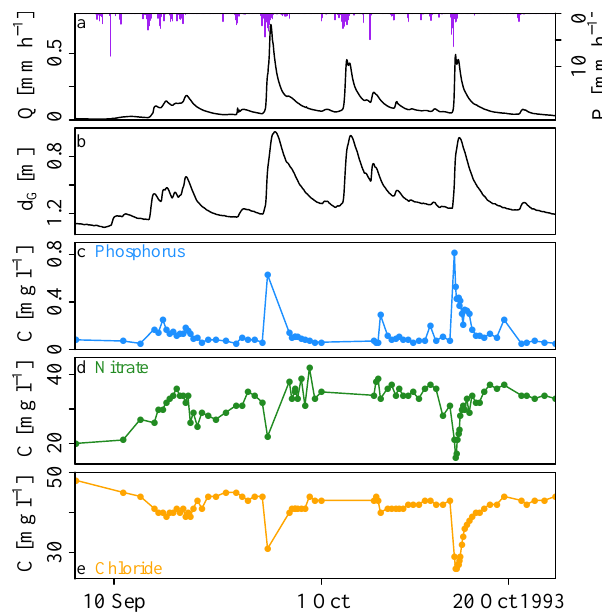
Figure 3. Activation of different flow paths revealed by water qual- ity data measured at the outlet of the Hupsel Brook catchment. (a) Precipitation and discharge. (b) Groundwater depth at the mete- orological station. (c) Phosphorus concentration (indicator for over- land flow, Rozemeijer et al., 2010b), (d) Nitrate concentration (in- dicator for drainpipe flow, Van der Velde et al., 2010b). (e) Chloride concentration (indicator for groundwater flow, Van der Velde et al.,